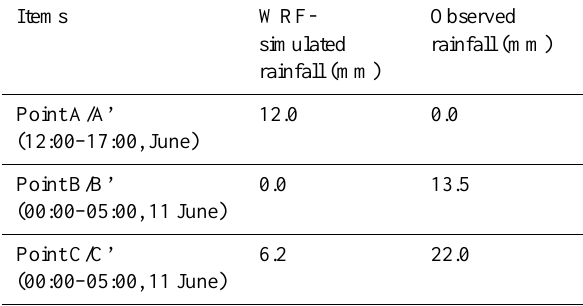
Table 2. Observed and WRF-simulated rainfall at points A/A’, B/B’ and C/C’ in Fig.